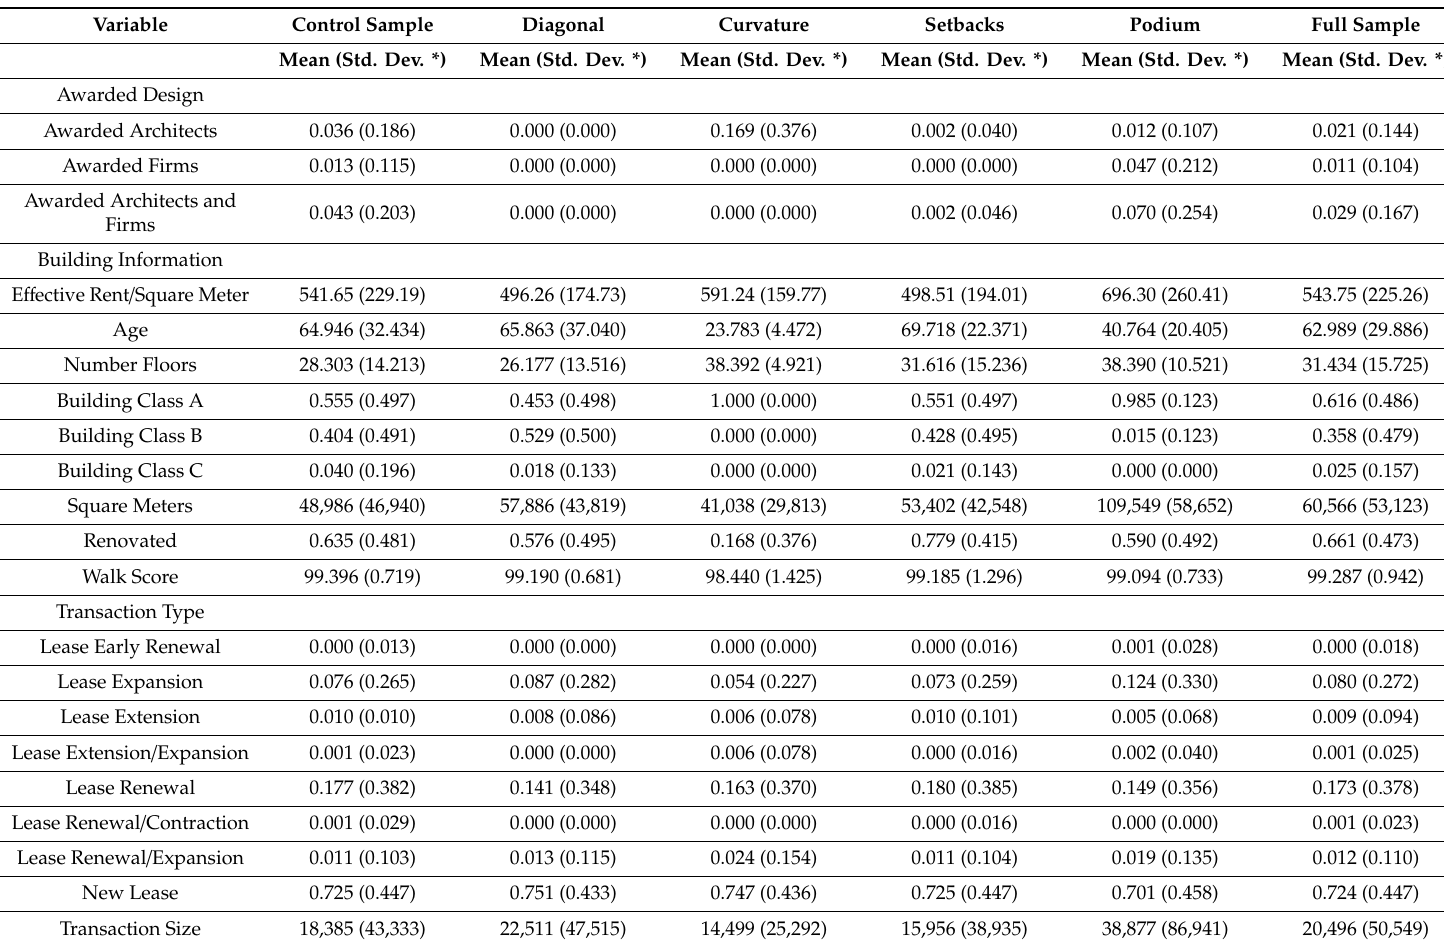
Table A1. Descriptive statistics of building characteristics and lease contract details by geometry. Table A1 highlights the mean and variation of building characteristics for the building samples with curvature, site location on a diagonal intersection, podium, and the New York City setback